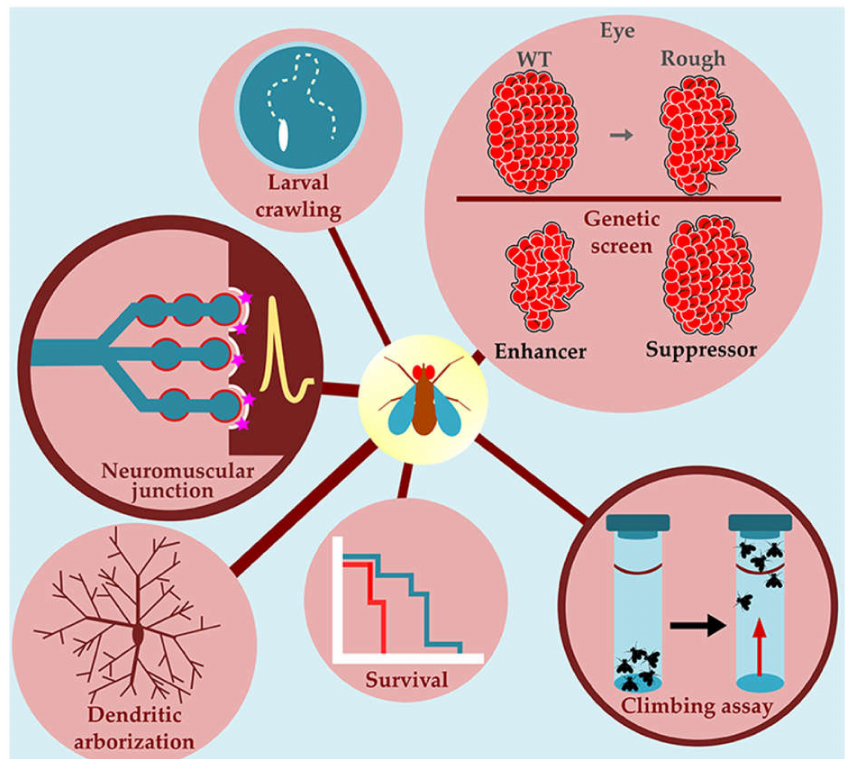
Figure 2. Drosophila is a model to study neurodegenerative diseases. Several neurode- generative diseases, including amyotrophic lateral sclerosis (ALS), have been modeled